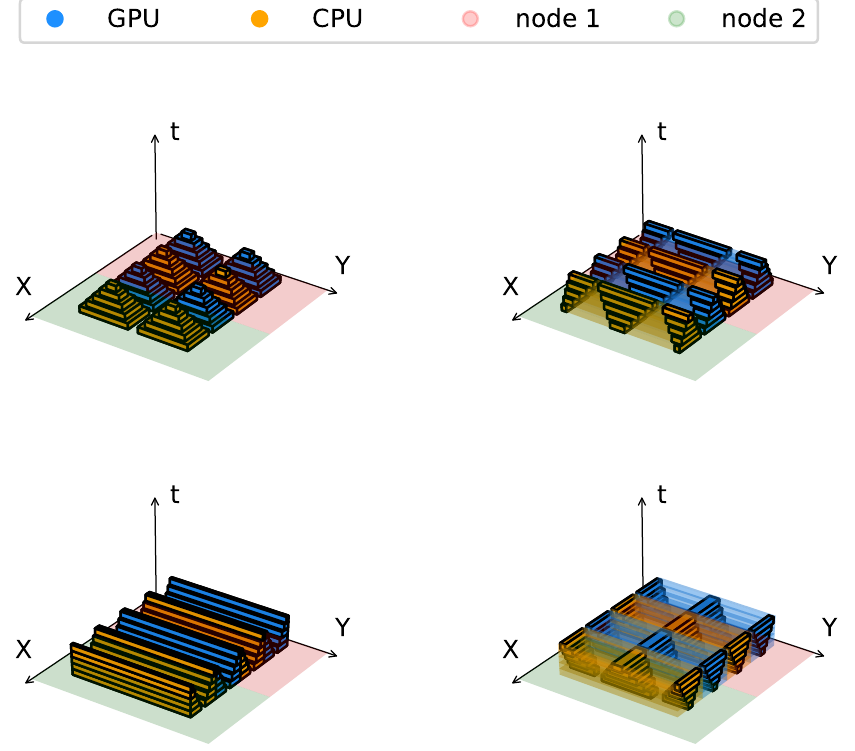
Figure 3. The first four steps in the swept solution process: Up-Pyramid ( top left ), Y-Bridge ( top right ), Communication ( bottom left ), and X-Bridge ( bottom righ